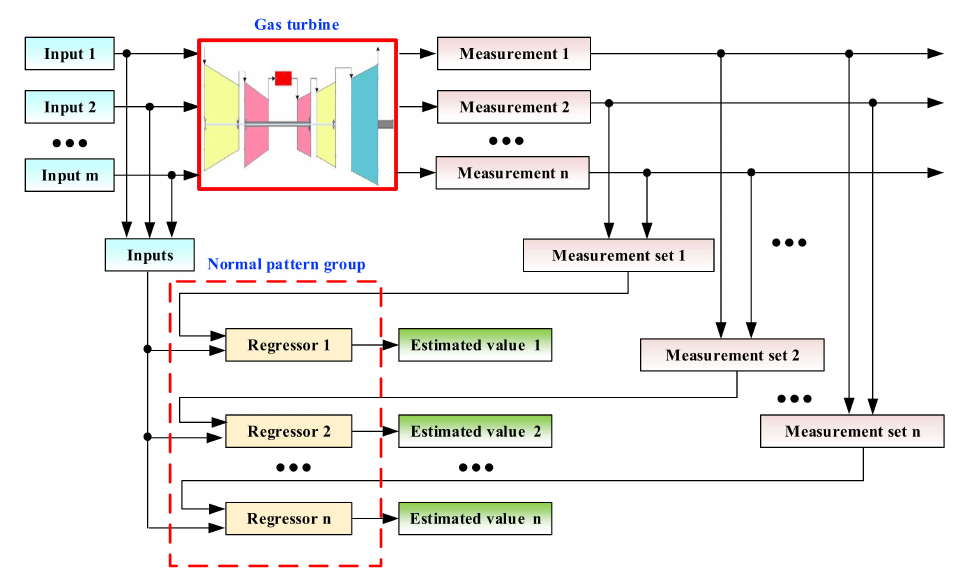
Figure 1. Architecture of normal pattern